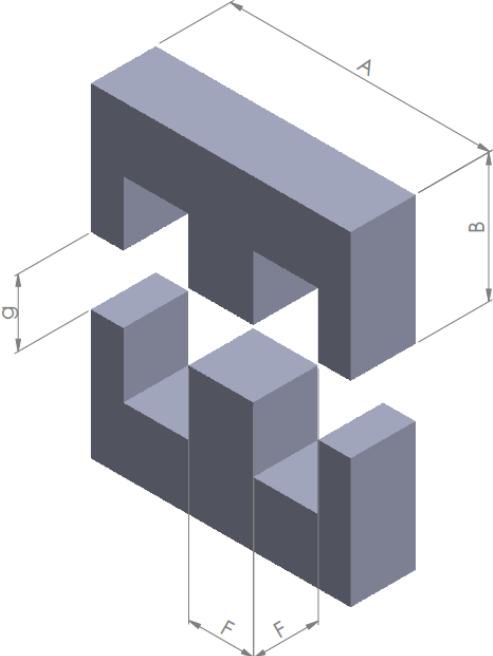
Figure 2. Three-dimensional representation of the double-E core geometry. The design variables are: the width of the E core A , the height of a single E-core B , the extension of the central column F , and the air gap’s length g .